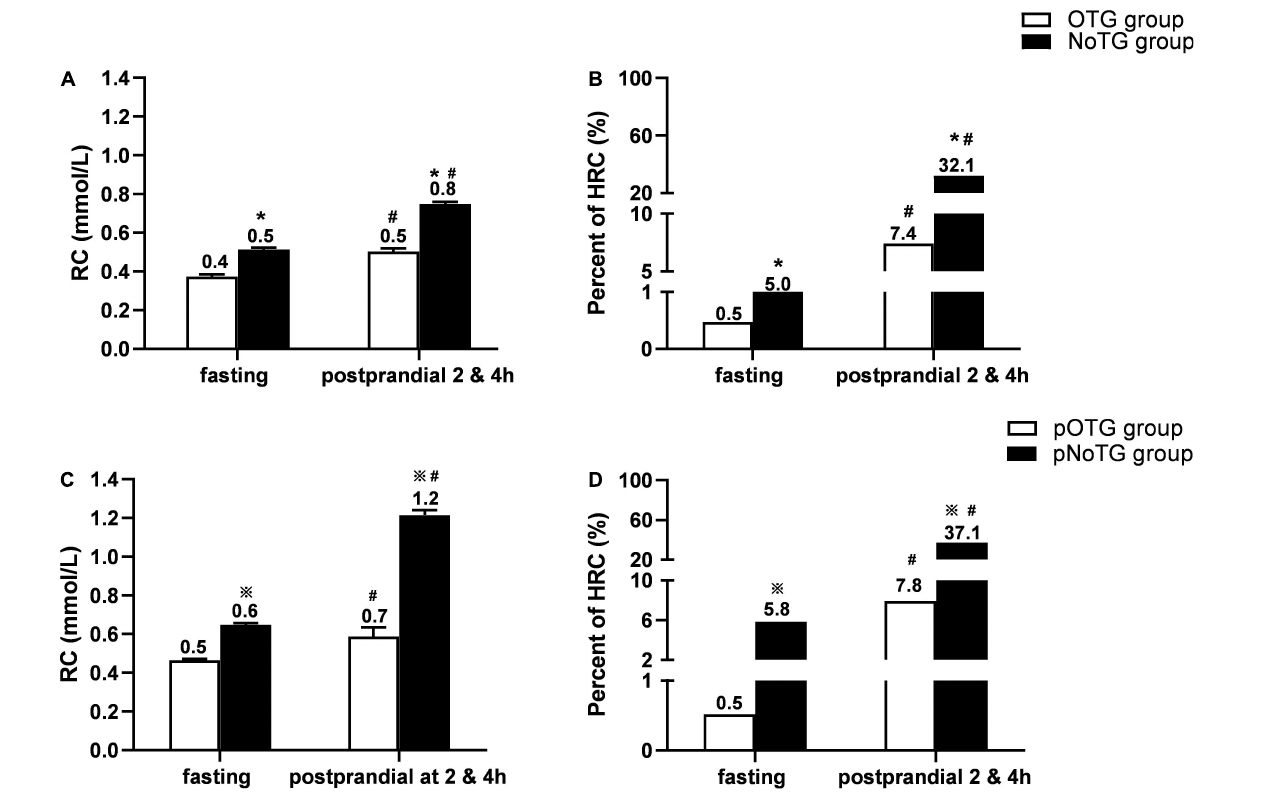
FIGURE4 Comparison of RC levels and percentages of HRC according to different cut-off values. (A) Comparison of levels of RC and percentages of high RC (HRC) between the OTG group ( n = 219) and NoTG group ( n = 399) classified by the fasting cut-off value of TG 1.2 mmol/L. (B) Comparison of percentages of high RC (HRC) between the OTG group ( n = 219) and NoTG group ( n = 399) classified by the fasting cut-off value of TG 1.2 mmol/L. (C) Comparison of levels of RC and percentage of HRC between the pOTG group ( n = 231) and pNoTG group ( n = 387) classified by the postprandial cut-off value of TG 1.56 mmol/L. (D) Comparison of percentages of HRC between the pOTG group ( n = 231) and pNoTG group ( n = 387) classified by the postprandial cut-off value of TG 1.56 mmol/L. Optimal triglyceride (OTG) group: fasting TG < 1.2 mmol/L. Non-optimal triglyceride (NoTG) group: fasting TG = 1.2 mmol/L. Postprandial optimal TG (pOTG, i.e. pTG4h < 1.56 mmol/L), and postprandial non-optimal TG (pNoTG, i.e. pTG4h = 1.56 mmol/L). * P < 0.05 when compared with the OTG group. # P < 0.05 when compared with the fasting state within the same group. P < 0.05 when compared with the pOTG group. Values are mean ± standard error (SE) or n (%) as appropriate.